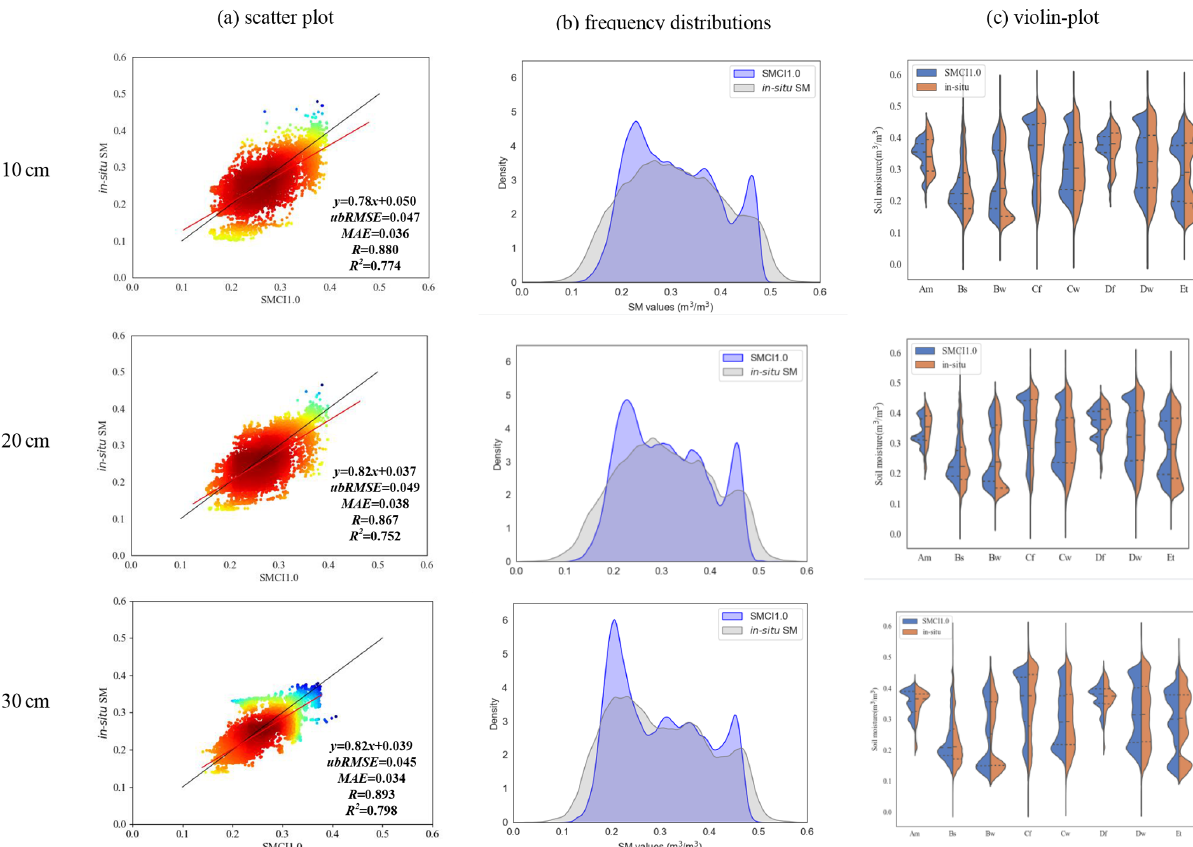
Figure 3. Same as Fig. 2 but for station-to-station